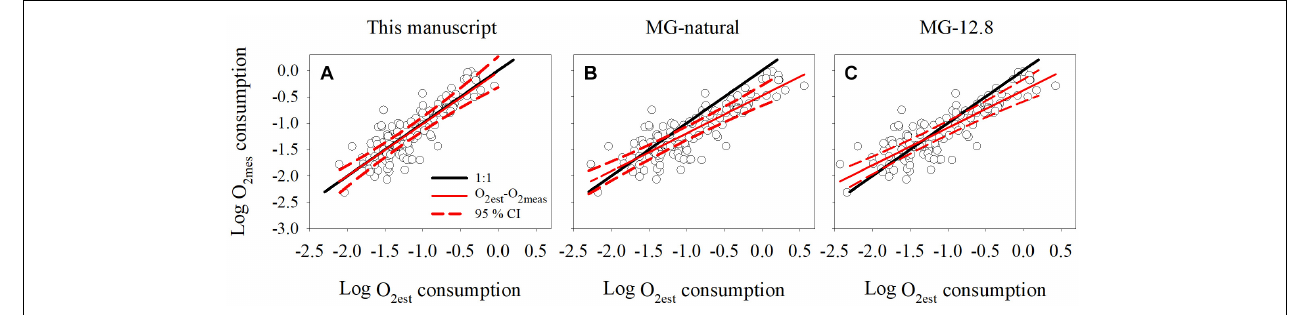
FIGURE 4 | Comparison between dissolved oxygen consumption measured using Winkler titrations and estimated by (A) regression model derived in this manuscript, (B) regression model derived from natural populations (MG-natural) reported in Martínez-García et al. (2009), and (C) coefficient factor derived from cultures (MG-12.8) reported in Martínez-García et al. (2009). The black line represents the 1:1 line and the red line the linear regression obtained between the measured (O 2meas ) and estimated (O 2est ) oxygen consumption. The red dotted lines indicate the maximum and minimum 95 % confidence interval for the O 2est -O 2meas regression